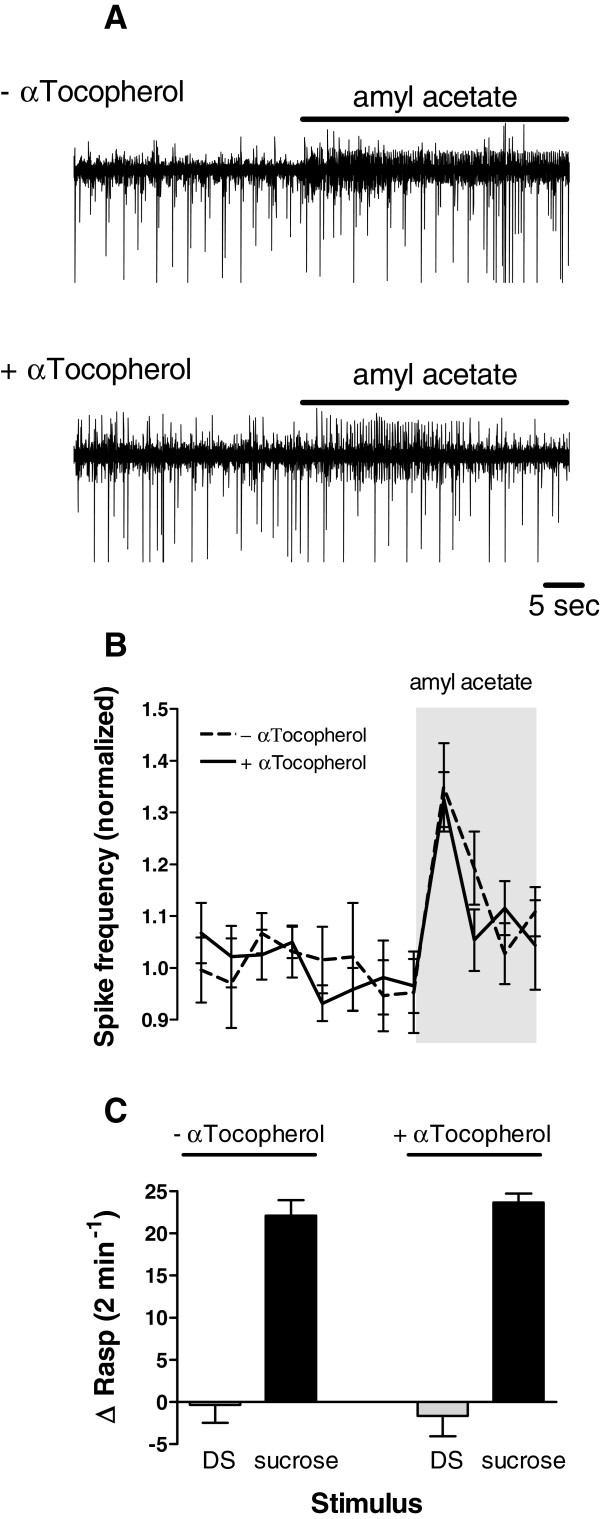
Effect of dietary α-tocopherol supplementation on chemosensory and motor function in senior animals. A.  Examples of extracellular recording of afferents in the superior lip nerve before and after application of n-amyl acetate (4 ppm) of senior animals with dietary supplementation of vehicle only (− αTocopherol; top trace) or α-tocopherol (+ αTocopherol; bottom trace). B. Average action potential frequency (bin size 30 sec) of afferents in superior lip nerve 4 minutes before and 2 minutes during amyl acetate application. There is no difference in response upon n-amyl acetate application between the two different treatment groups C. Average change in the number of rasps evoked by application of pond water (DS) or sucrose (0.4%). Only sucrose induced a robust but similar response in senior animals fed with dietary supplementation of vehicle only (− αTocopherol) or α-tocopherol (+ αTocopherol).